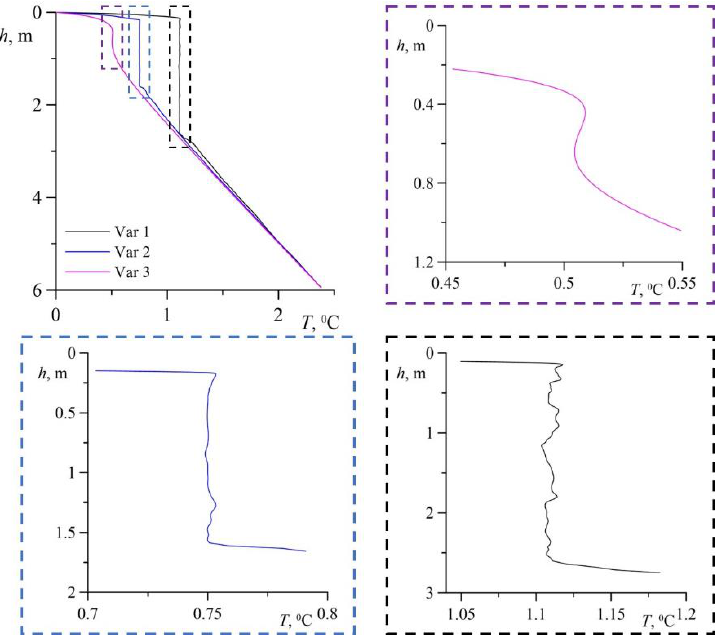
Figure 6. Temperature profiles for the different variants (4th day, 3 p.m.).